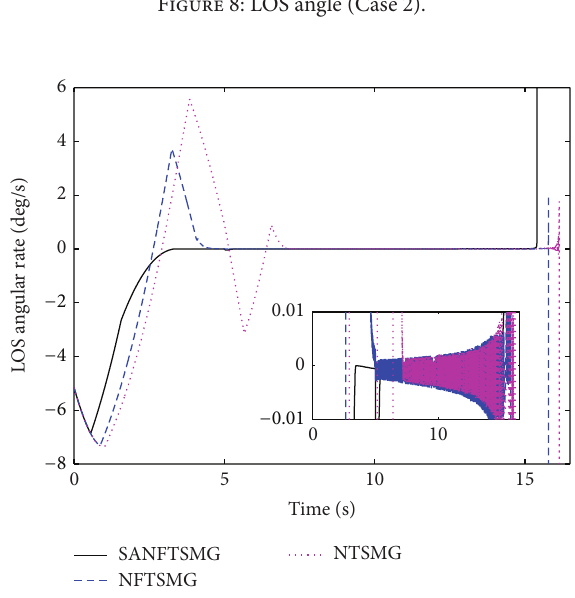
Figure 8: LOS angle (Case 2).